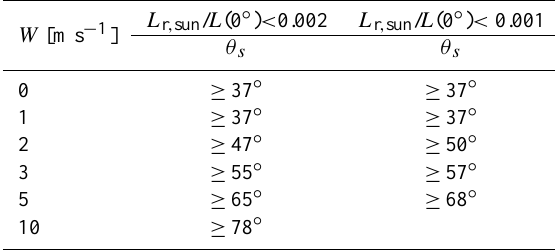
Table 2. Ranges of θ s where sun glitter can be neglected. L r , sun / L (0 ◦ ) < 0.002 L r , sun / L (0 ◦ ) < W [ms − 1 ]